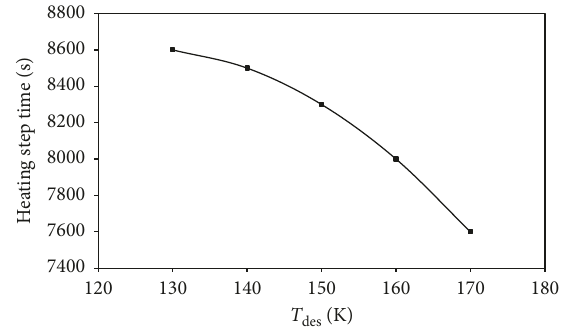
Figure 18: Variations of heat duration step versus desorption temperature.